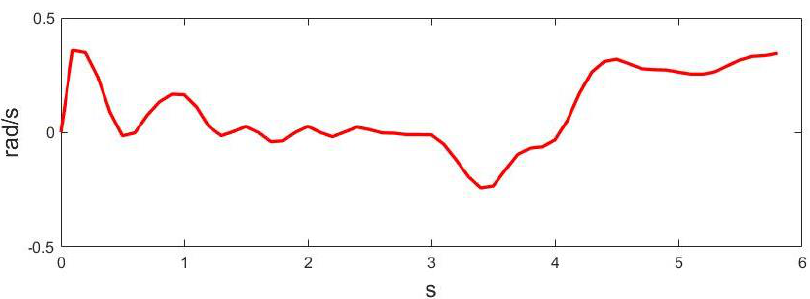
Figure 21. Angular velocity generated in the human-involved dynamic driving scenario.